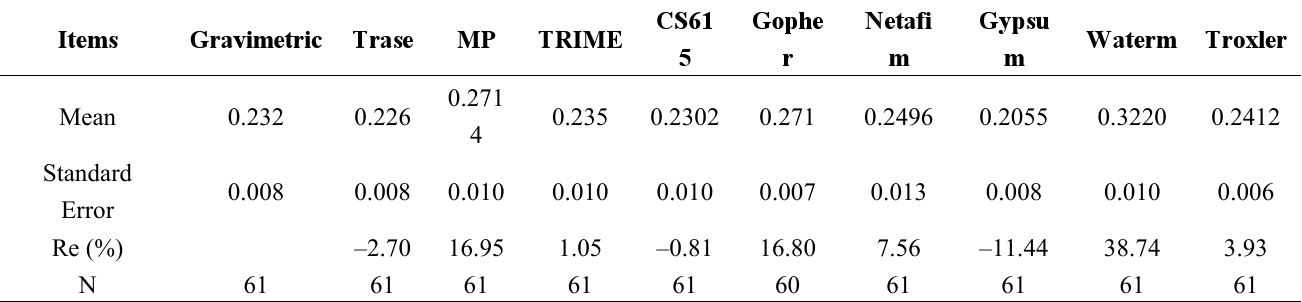
Table 2. Statistics of volumetric soil water content (cm 3 /cm 3 ) obtained by different